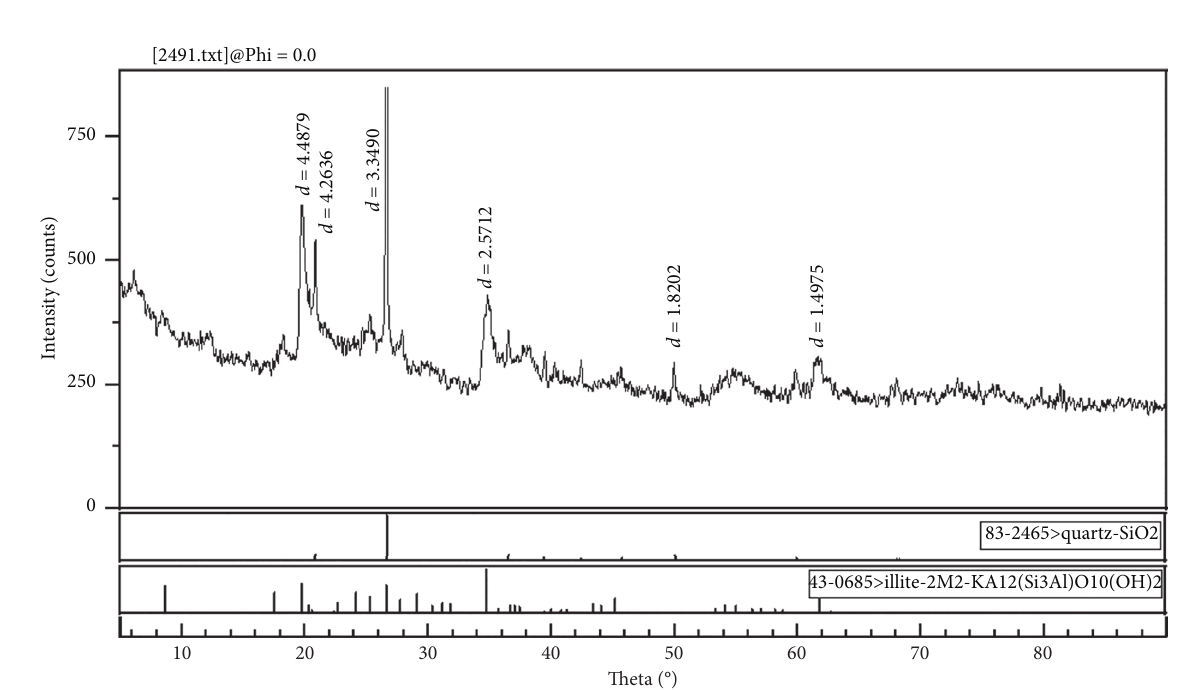
Figure 2: X-ray diffraction pattern of peat